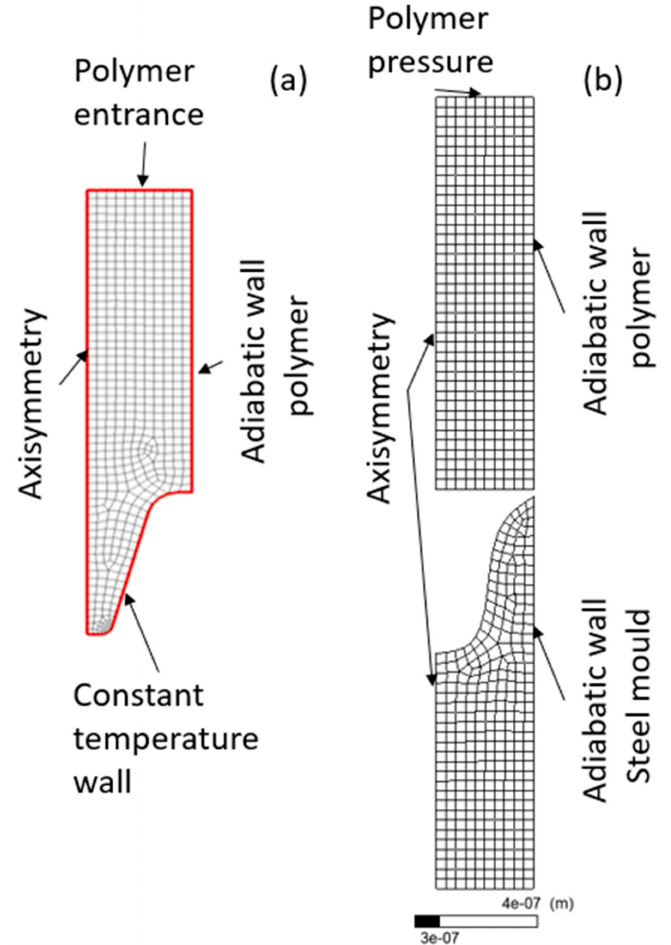
Figure 4. Mesh and boundary conditions used in ( a ) Fluent and ( b )